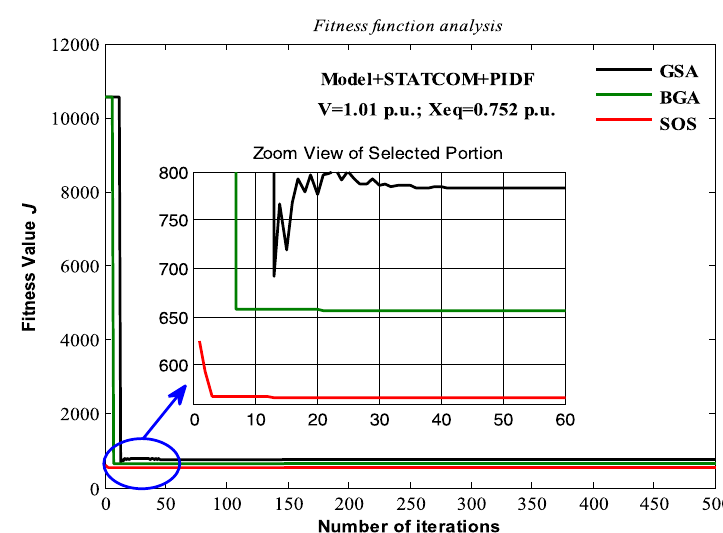
Fig. 4 Convergence profile of the fitness function ( J ) under V = 1.01 p.u. and Xeq = 0.752 p.u